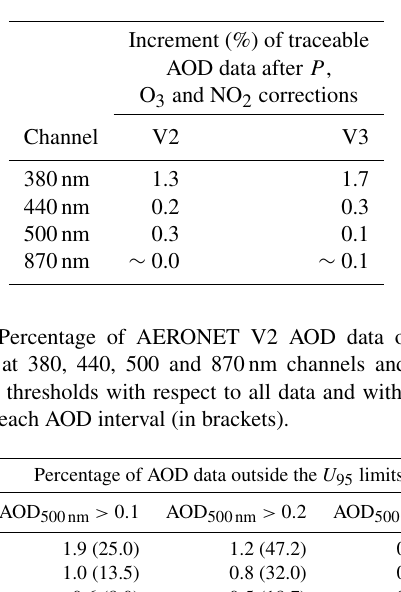
Table 9. Percentage (%) of additional traceable AERONET-Cimel AOD 1min data (V2 and V3) after correcting for pressure and total column O 3 and NO 2 for the period 2005–2015.